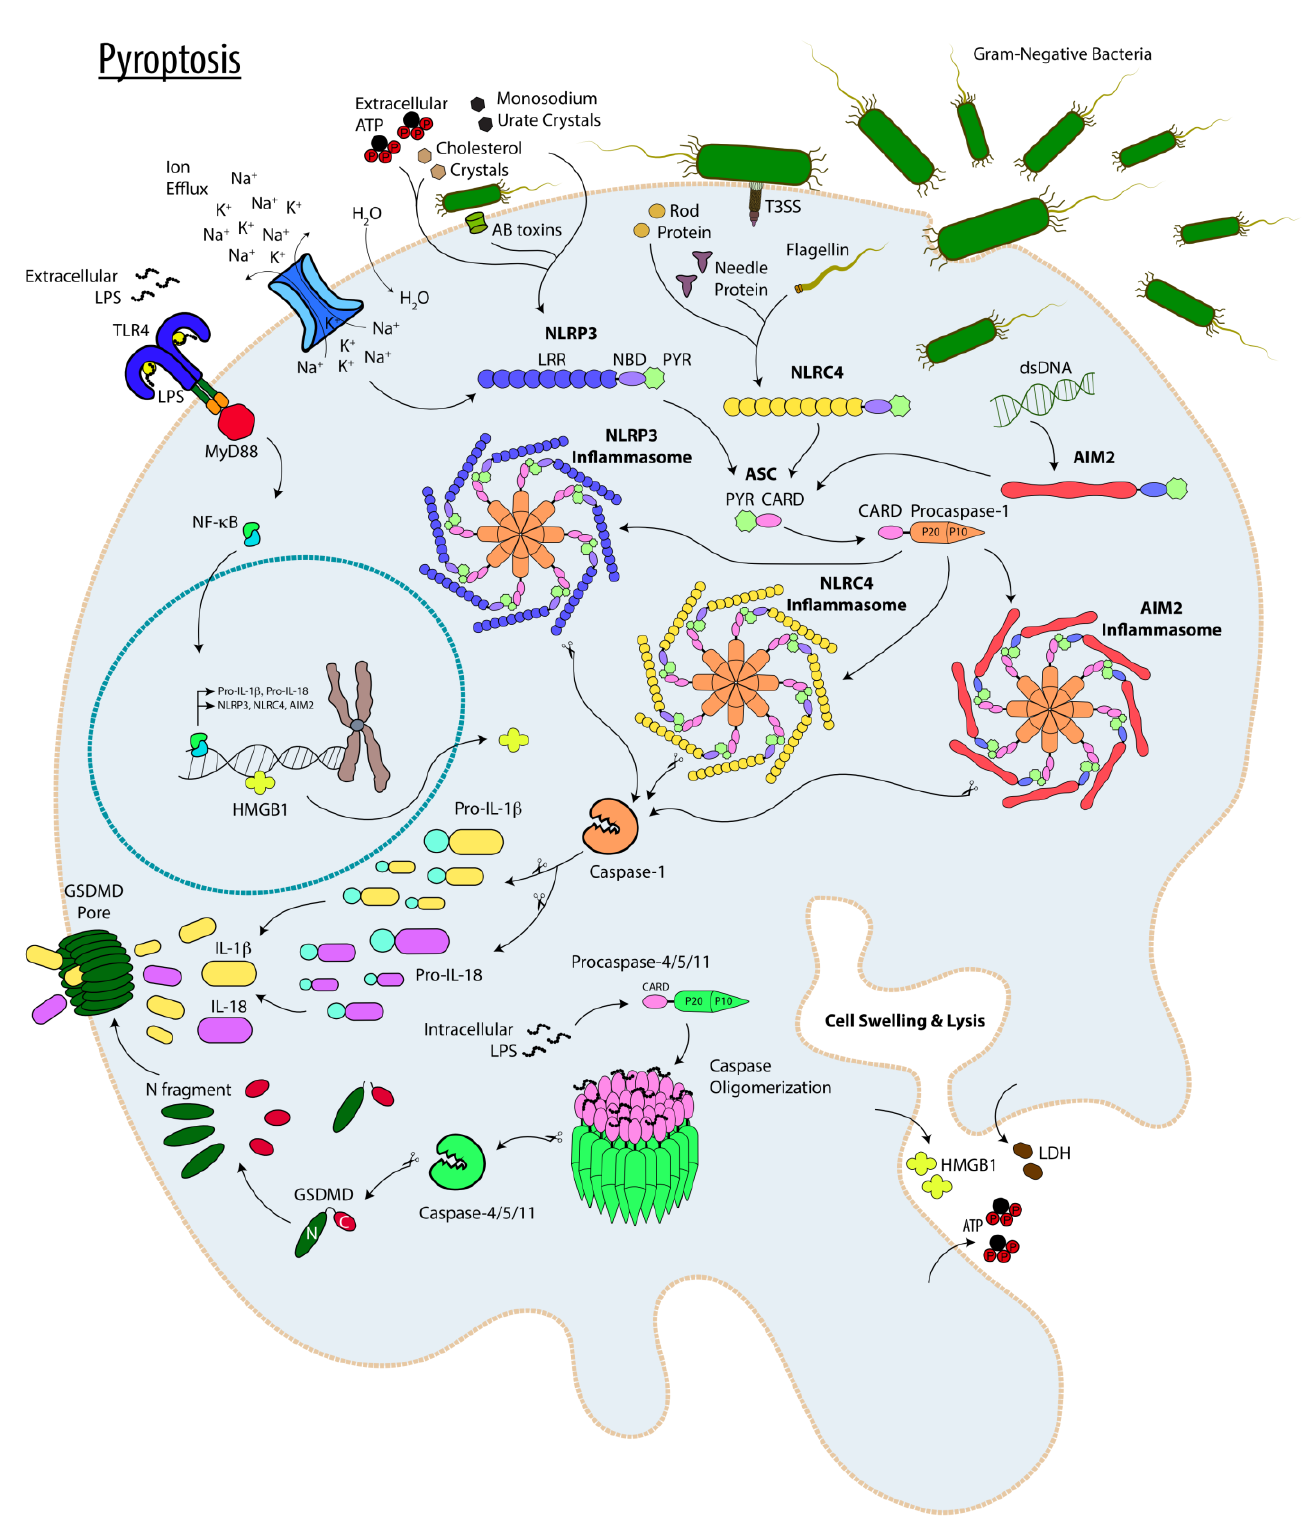
Figure 2. Pyroptosis. The main players involved in pyroptotic programmed cell death are depicted. The pathways are described in the text.